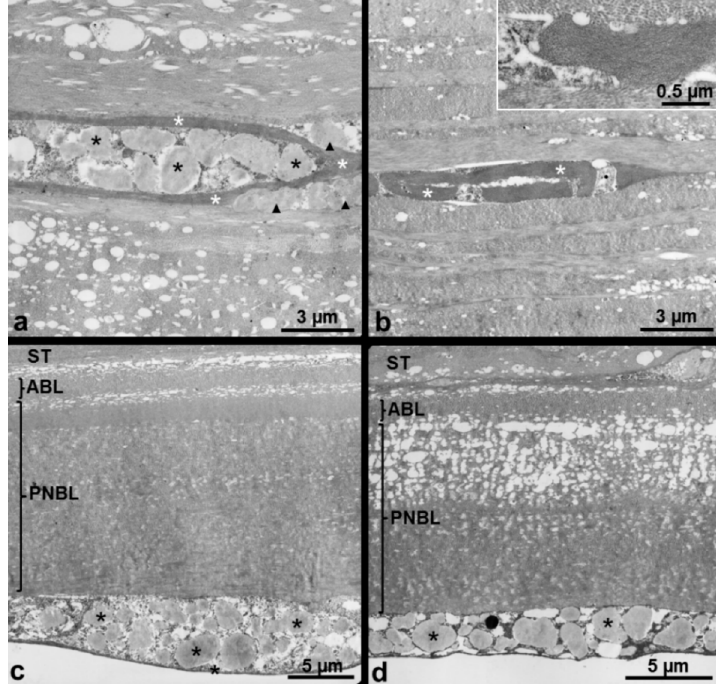
Figure 3: Transmission electron microscopy of the excised right